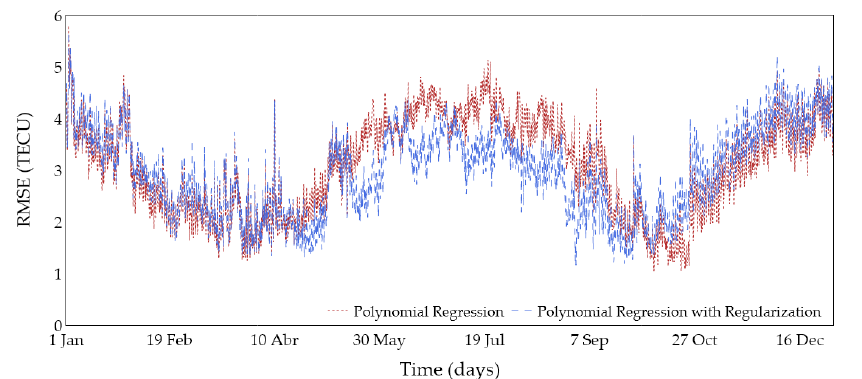
Figure 17. RMSE for Linear Regression.